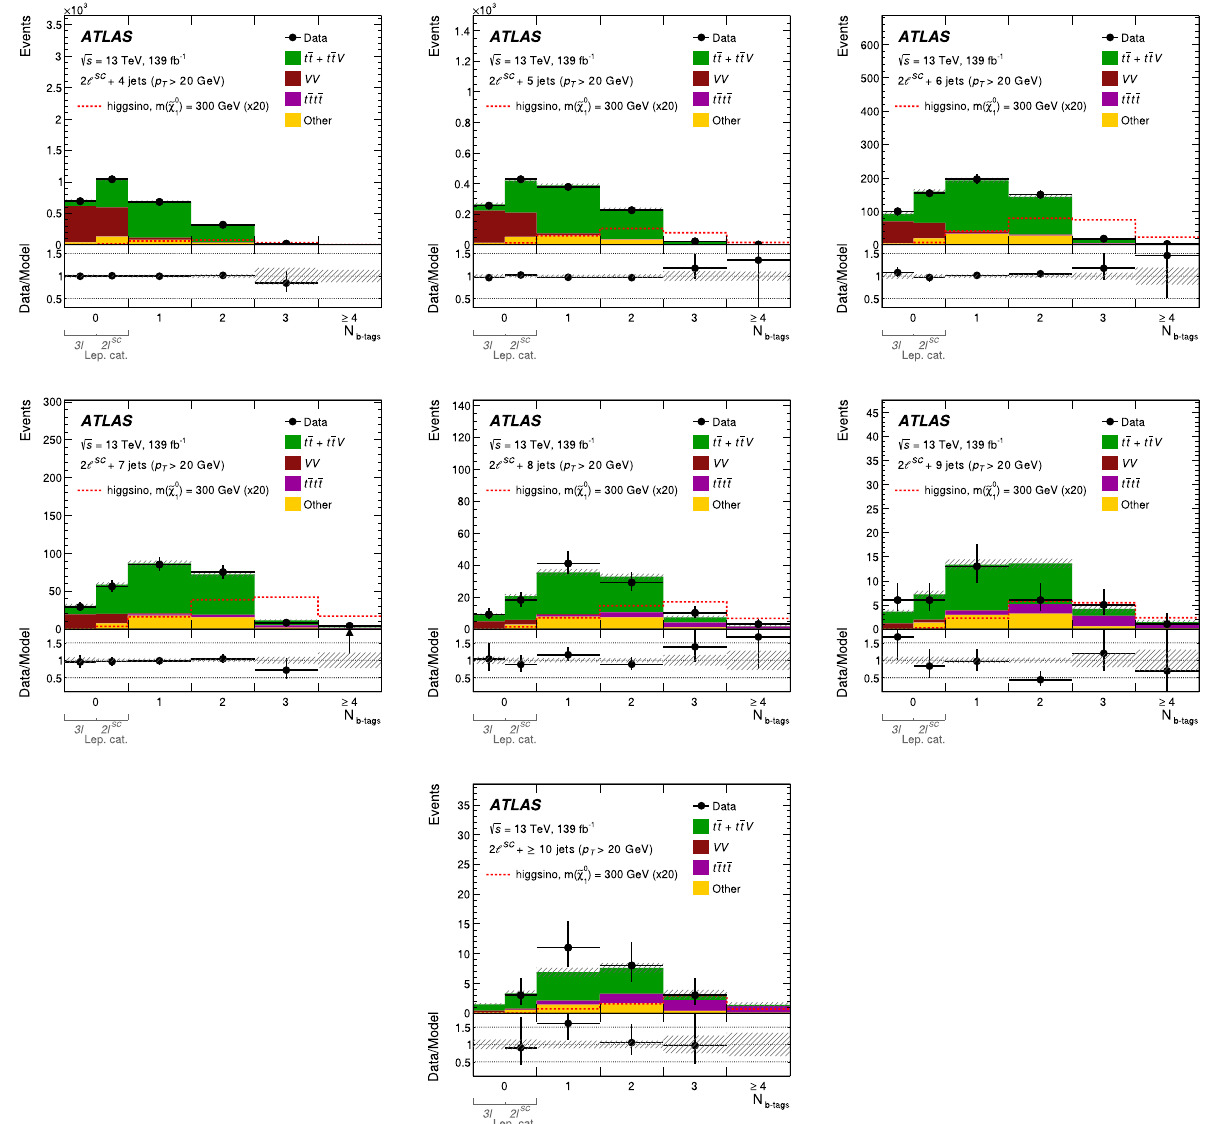
Fig. 6 The observed data event yields and the corresponding estimates forthebackgroundsinthedifferent b -jetmultiplicitybinsforthe20GeV jet- p T threshold regions defined for the EWK analysis in the 2 (cid:3) sc cate- gory. The background shown is estimated by including all bins in the fit.